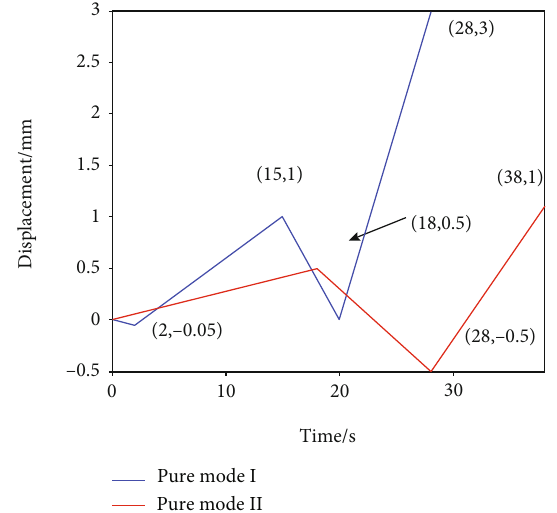
Figure 8: Displacement versus time for pure mode I and pure mode II